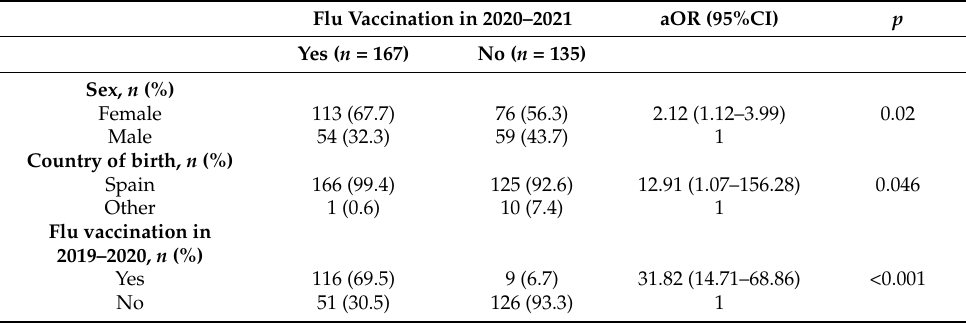
Table 4. Variables included in the multiple logistic regression